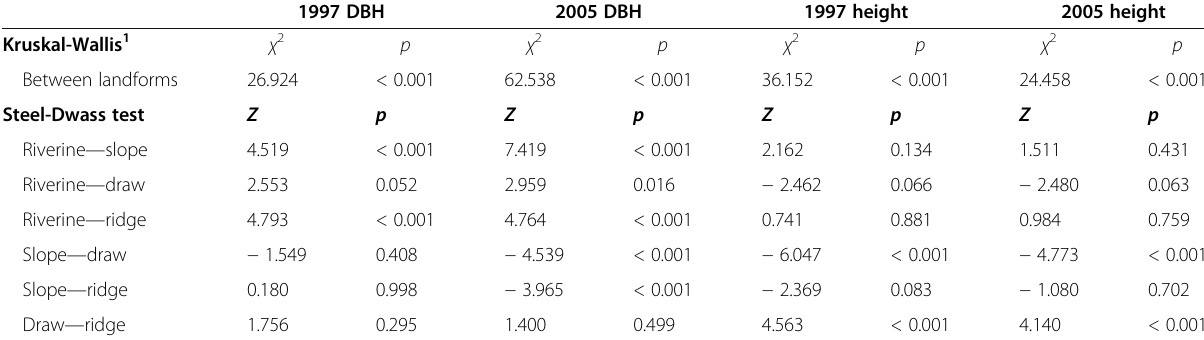
Table 4 Statistical tests comparing forest structural metrics between landform types